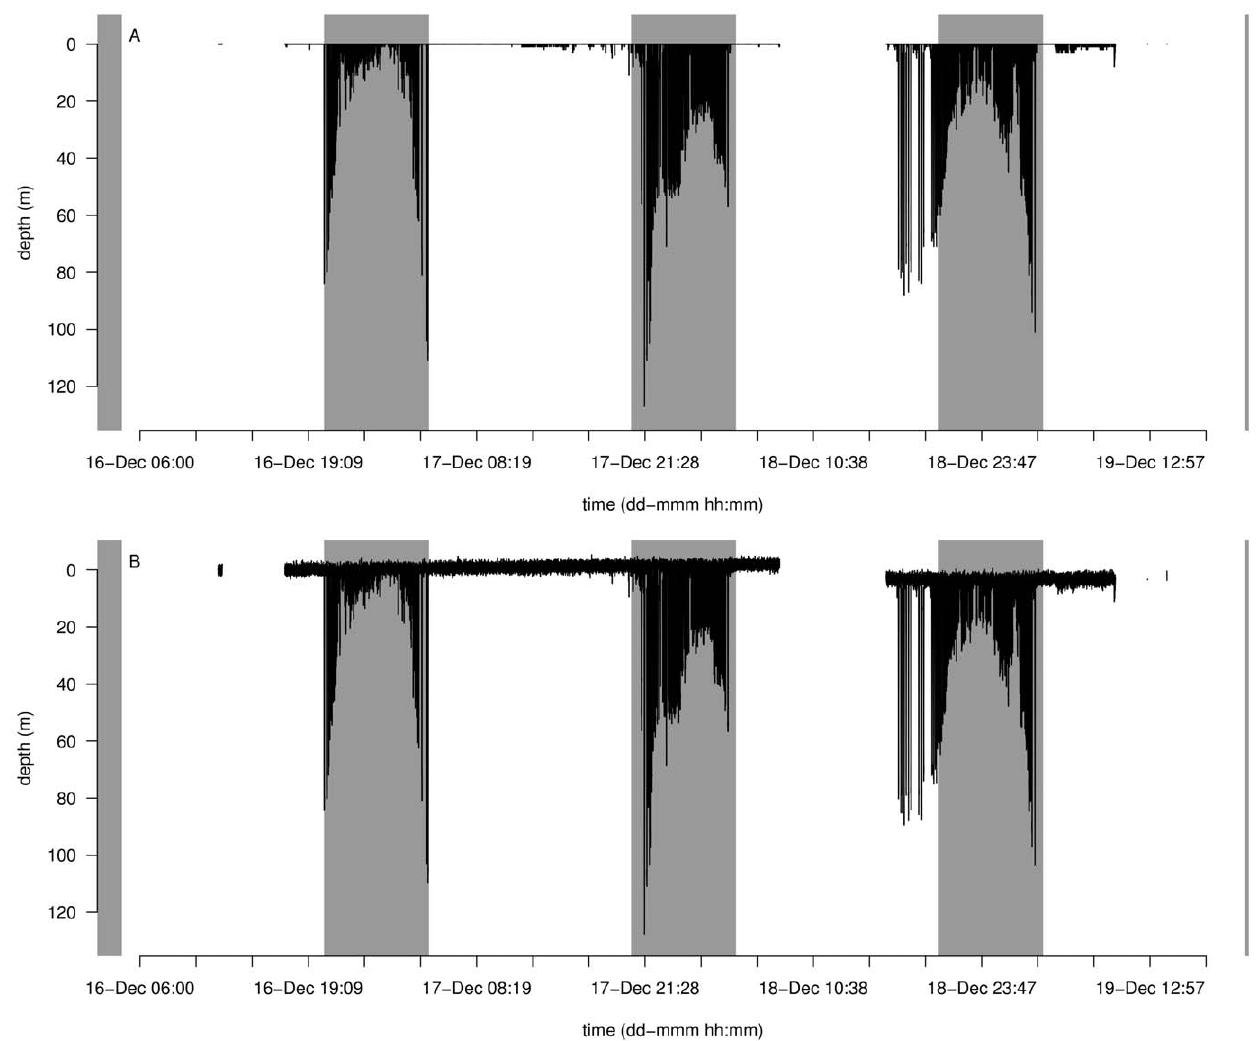
Figure 1. Subset of ‘‘perfect’’ data set to be corrupted and used as reference to measure performance of the ‘‘filter’’ method for zero offset correction (A), and corrupted data set to be used as input (B).